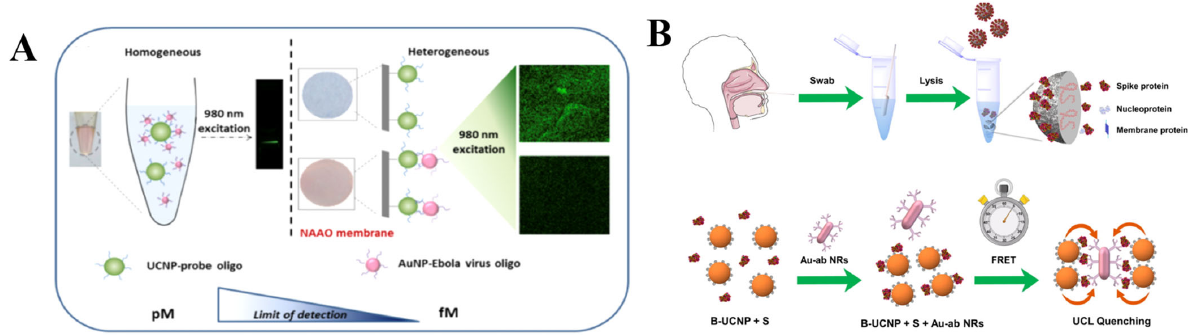
Figure 5. ( A ) Comparison illustration of homogenous and heterogeneous sensor for Ebola virus detection. Reprinted with permission from reference [80]. ( B ) Schematics of COVID S protein detection using plasmon modulated upconversion biosensing system . Reprinted with permission from reference [81].